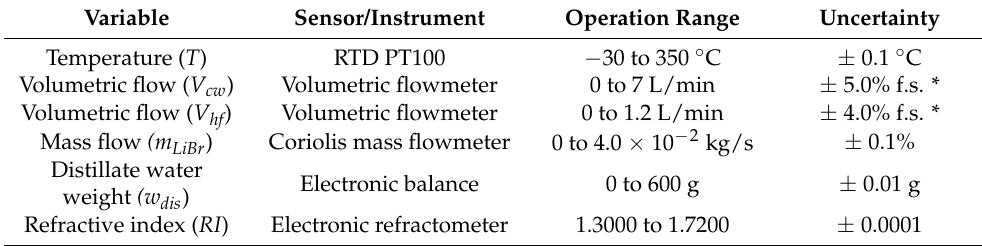
Table 3. Uncertainty of the measured variables.